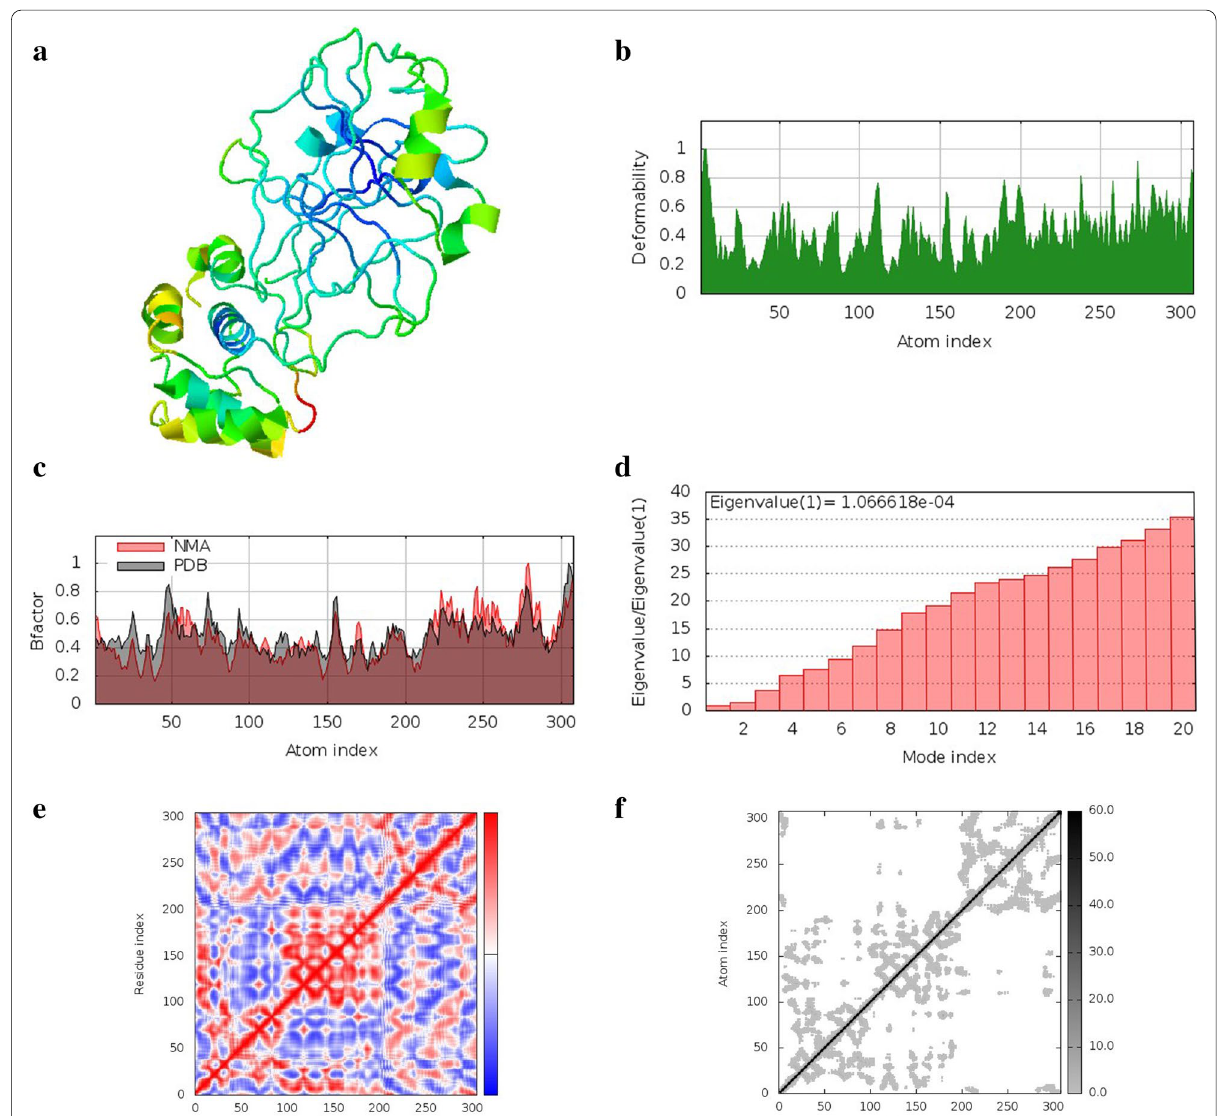
Fig. 9 Normal mode analysis of quercetin-3-neohesperidoside-7-rhamnoside and 3C-like protease complex a NMA mobility, b deformity, c B-factor, d eigenvalues, e co-variance map, f elastic network of